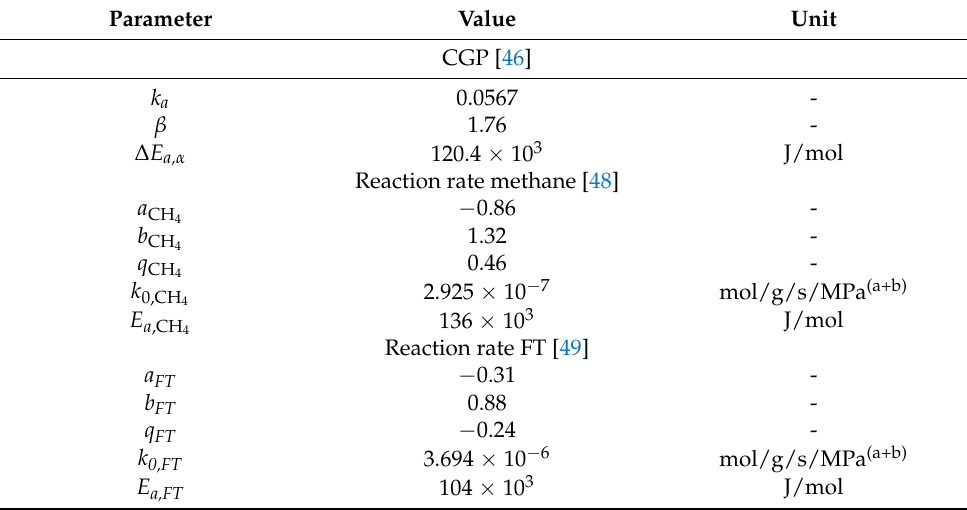
Table 1. The kinetic parameter values for the calculation of the chain growth probability (CGP) and reaction